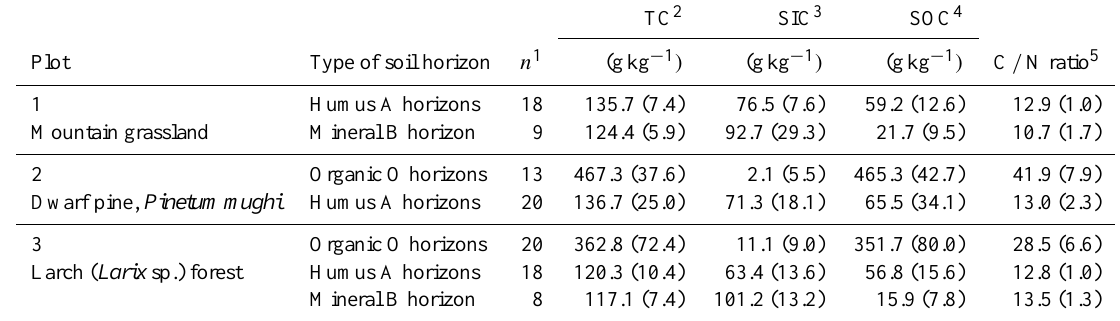
Table 2. The concentration of TC, SIC, SOC, and C / N ratio in analyzed soils – mean values (standard deviation in brackets).